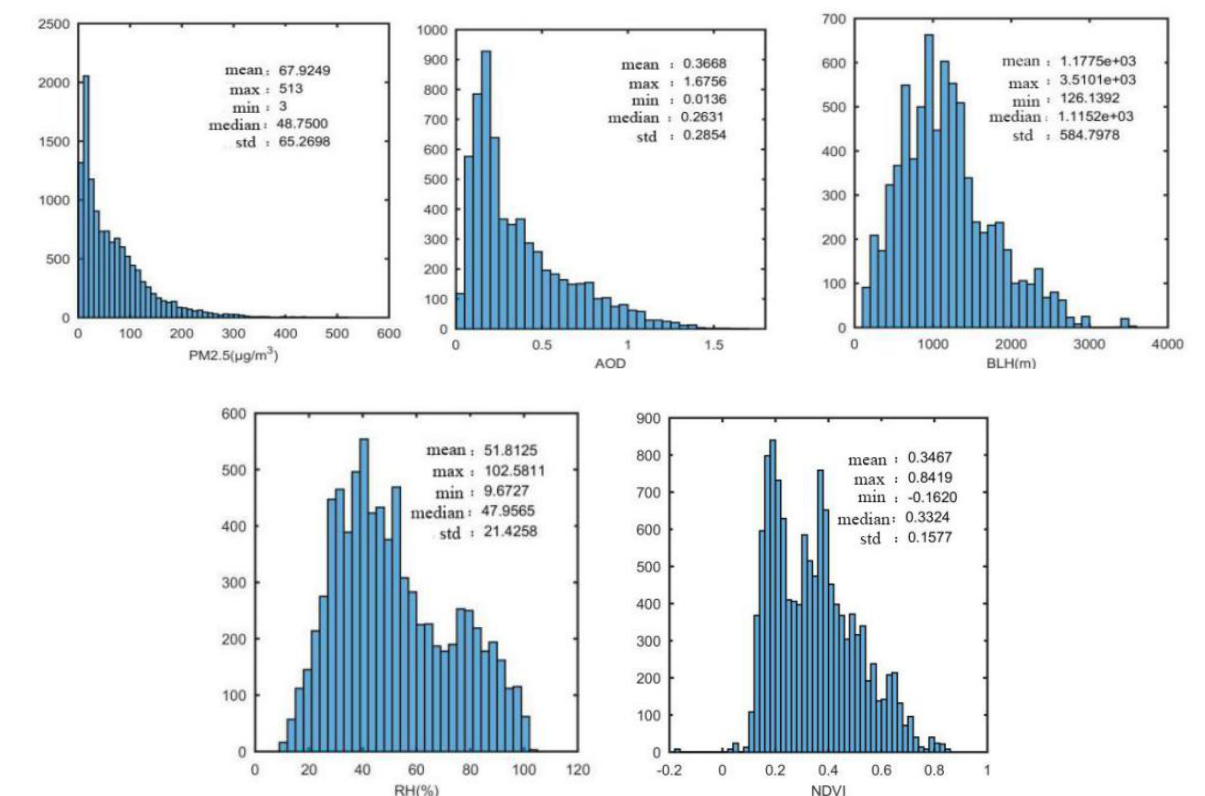
Figure 2. Descriptive statistics of the dataset